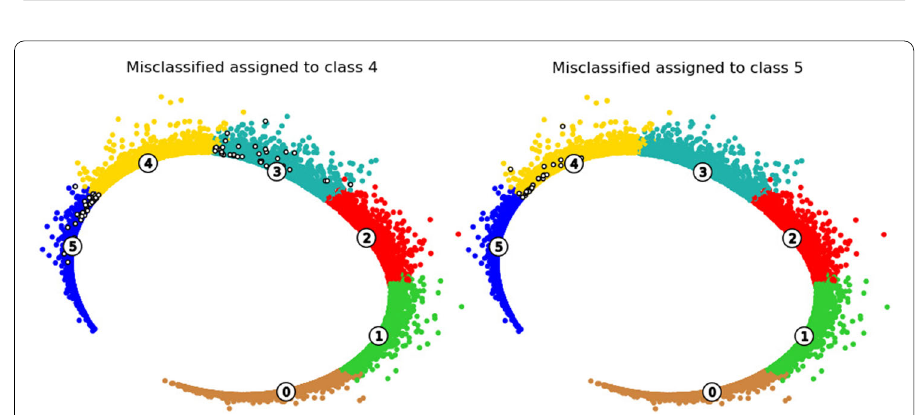
Fig. 12 Misclassified examples (classes 4 and 5)